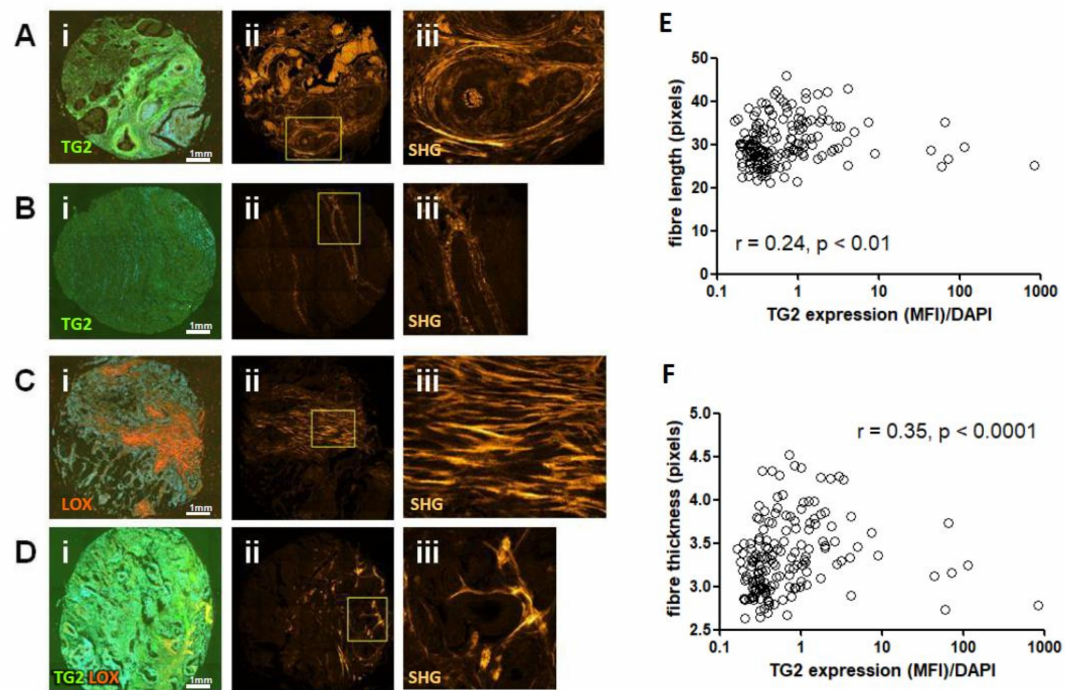
Figure 7. TG2, LOX and co-localisation of both correlate with collagen structural parameters determined by SHG. High TG2 expression ( A , green staining in panel i) was associated with regions of thicker collagen fibres which surround the epithelium ( A , panel ii and magnified image panel iii). By contrast, low TG2 expression ( B , panel ii) was associated with regions of thinner fibres (panel ii and magnified image panel iii). High LOX staining ( C , red staining in panel i) associated with thick fibres extending extensively throughout the stroma (panel ii and magnified image panel iii). Areas of high co-localisation of both enzymes ( D , panel i, yellow colouration) showed distinctive, localised, thickened fibre bundles ( D , panel ii and magnified image panel iii). Correlation analysis of staining and SHG imaging showed a significant relationship between TG2 and fibre length ( E ), and fibre width ( F